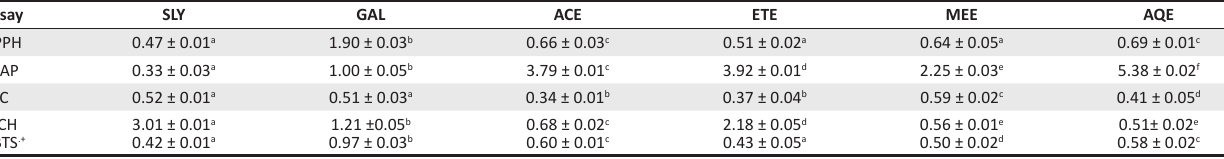
FIGURE 5: Percentage inhibition of 2,2’-Azino-bis (3-ethylbenzothiazoline-6- sulphonic acid) potentials of Acalypha godseffiana (leaves) extracts. TABLE 3: IC (mg/mL) of Acalypha godseffiana (leaves) in different anti-oxidative models. 50